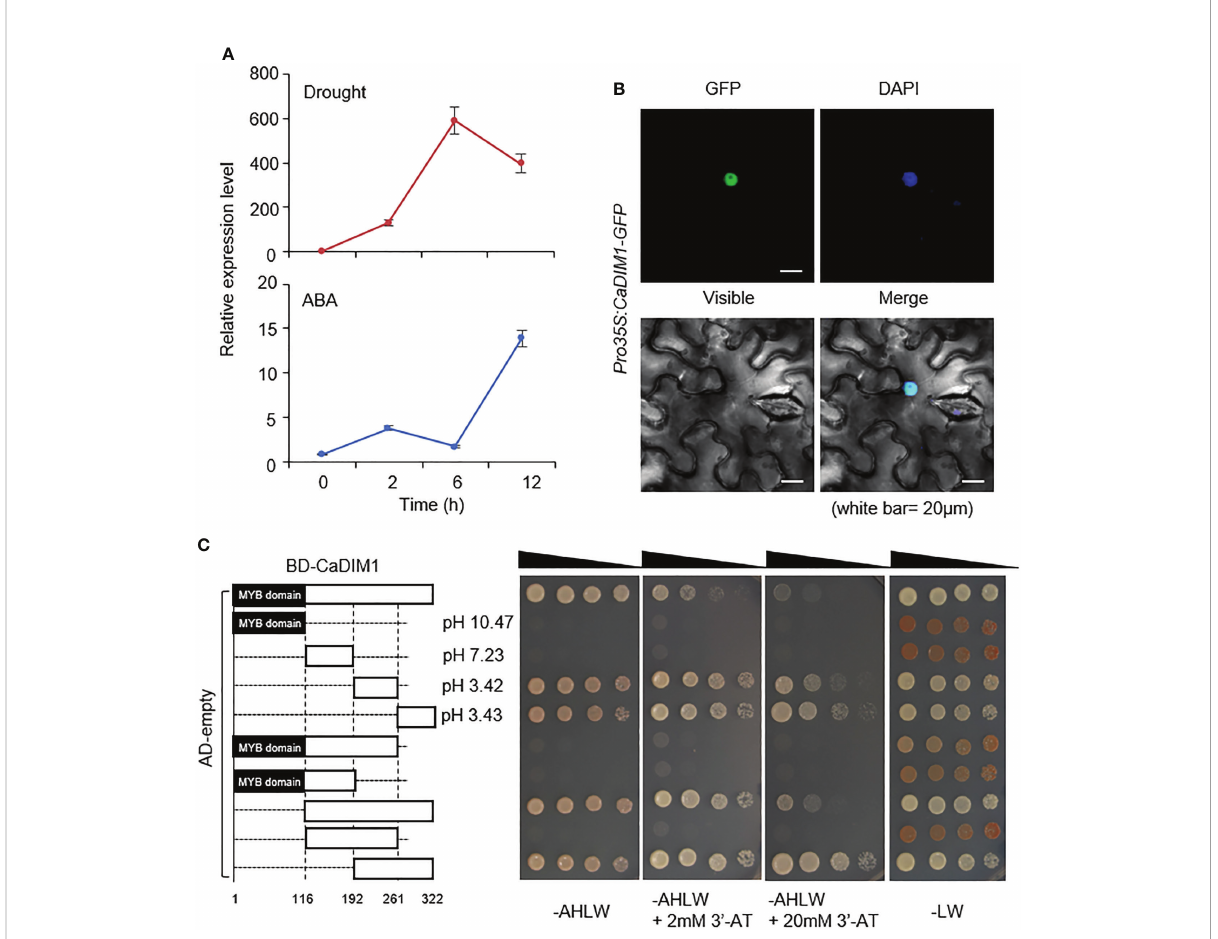
FIGURE 1 Molecular characterization of CaDIM1. (A) Expression levels of CaDIM1 in the pepper leaves after treatment with abscisic acid (ABA) (100 m M), or drought. The pepper Actin1 ( CaACT1 ) was used as an internal control. (B) Subcellular localization of green fl uorescent protein (GFP)-tagged CaDIM1 proteins. Expression of GFP in Nicotiana benthamiana leaves was detected under a confocal microscope. 4 ′ ,6-Diamidino-2- phenylindole (DAPI) was used as a nuclear marker. The white scale bars represent 20 m m. (C) Transactivation of the GAL4-responsive promoter by full-length and truncated forms of CaDIM1 fused to the GAL4 DNA-binding domain in the yeast strain AH109. Yeast harboring each construct were grown on selection media (SC-adenine-histidine-leucine-tryptophan [AHLW] SC-leucine-tryptophan [LW]). Representative images were taken at 5 days after incubation. BD, DNA-binding domain; AD, activation